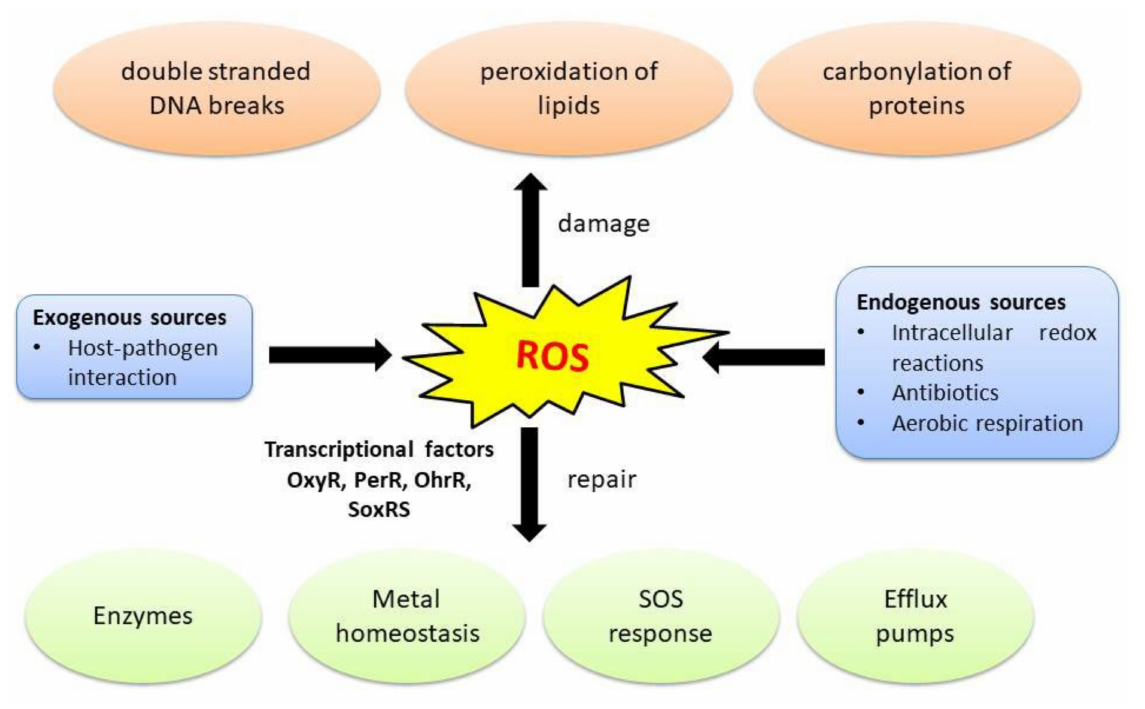
Figure 2. Overview of oxidative stress in bacteria and their response to the stress. Accumulation of ROS causes oxidative stress in bacteria. Both exogenous and endogenous sources contribute to oxidative stress. ROS damage bacterial cells by causing double stranded DNA breaks, peroxidation of lipids, and by carbonylation of proteins. Bacteria respond to oxidative stress using a battery of repair mechanisms such as production of protective enzymes, metal homeostasis, SOS response, and efflux pumps. Oxidative stress response in bacteria is regulated by transcriptional factors OxyR, PerR, OhrR, and